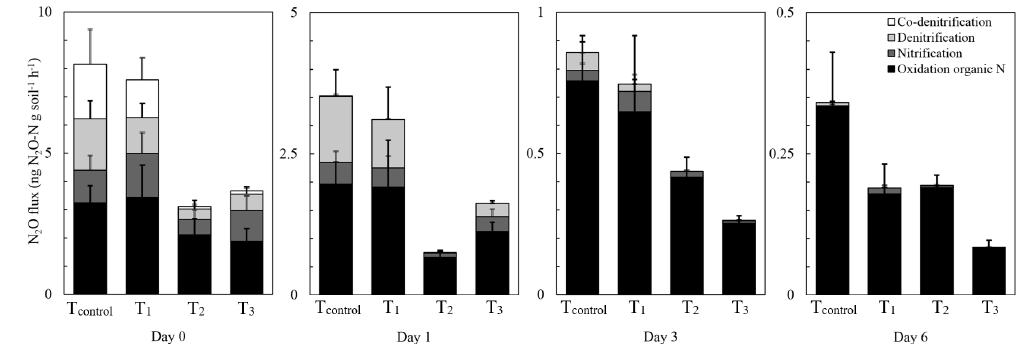
Figure 6. N 2 O flux divided into four processes at different time points after fertilization. N 2 O fluxes based on average flux from soil labelled with 15 NH 4 NO 3 Gly or NH 15 NO 3 Gly. The portrayed flux per process is an average over the four plots per treatment. Error bars are standard 4 error of the mean. The scale of the y axis is different for each time